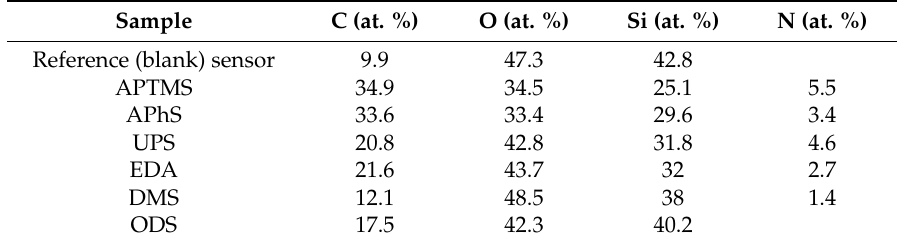
Table 1. Surface composition (in atomic %) of SiO 2 sensors before and after silanization with different silanes (6 h of deposition at 25 ◦ C in acetonitrile). Sample C (at. %) O (at. %) Si (at.